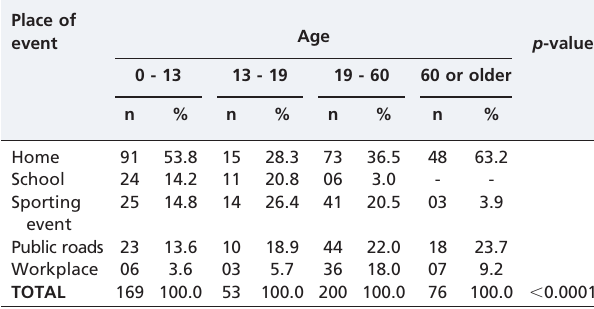
Table 4 - Associations between place of event and age of victims. Sergipe, Brazil,